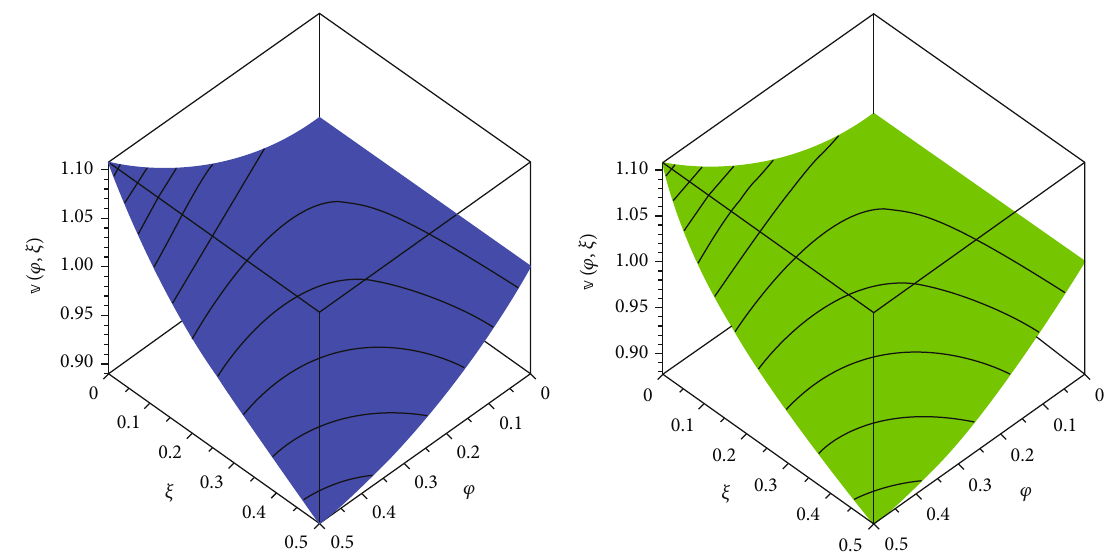
Figure 2: Di ff erent fractional-order of ℘ = 0 : 6 and 0.4 of Example